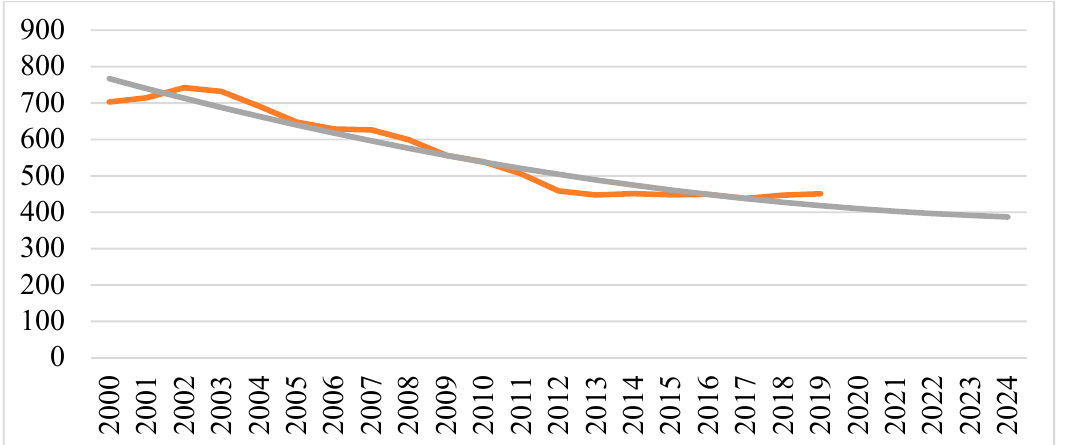
Figure 3. Total meat production in the Czech Republic in the years 2000–2019, including a forecast for five years ahead (in thousands of tons) (silver line represents prediction; red line represents observed data) [27].